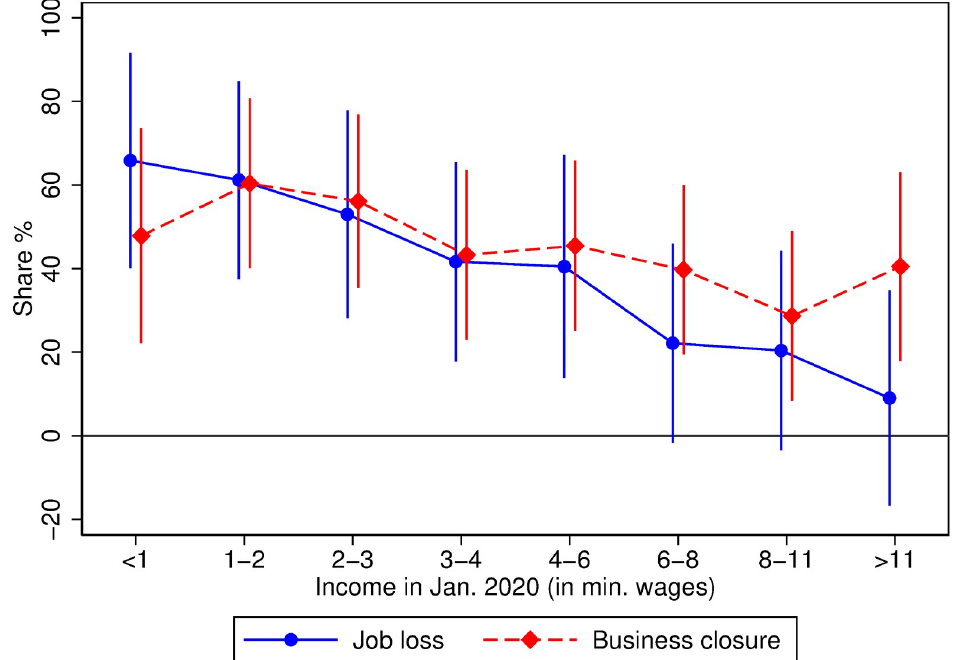
Fig 1. Higher rates of job loss and business closure among households in the lowest income group. Point estimates and 95 percent confidence intervals for regressing the labor market outcome on income bin indicators and country fixed effects. Data is weighted using within- and cross-country weights. See Empirical Methods in the Supplementary Information section for details.